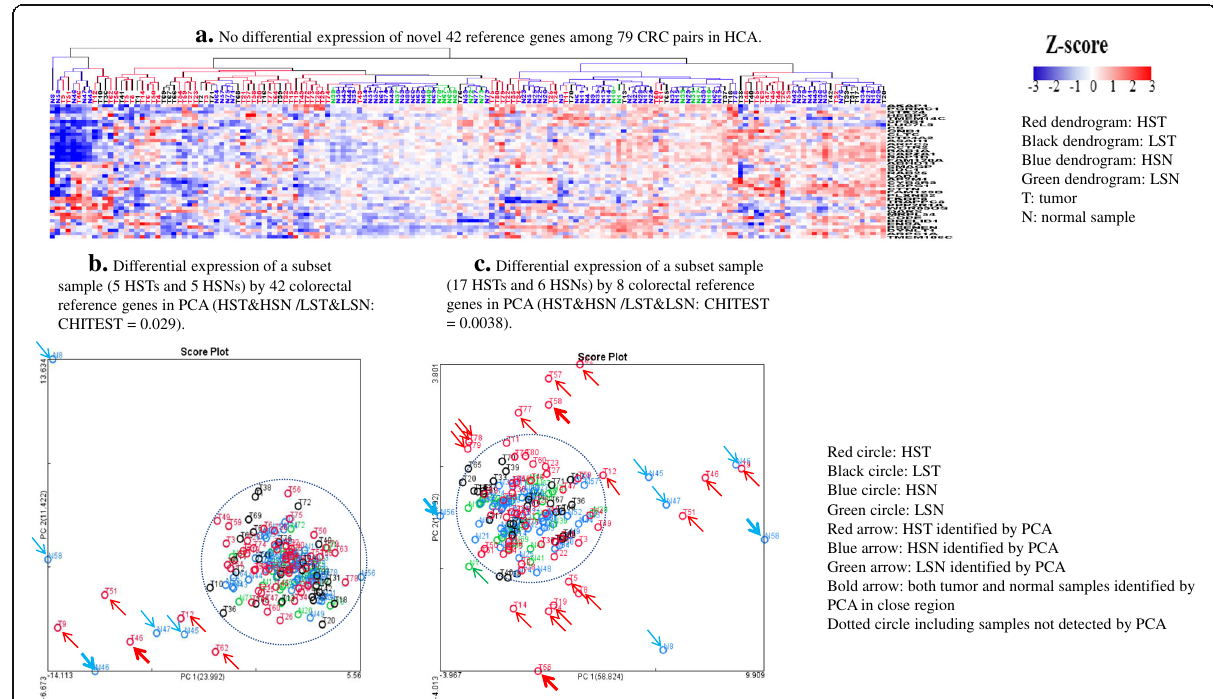
Fig. 3 HCA and PCA analysis of colorectal 42 reference genes in 79 CRC pairs. a . No differential expression of novel 42 reference genes among 79 CRC pairs in HCA. b . Differential expression of a subset sample (5 HSTs and 5 HSNs) by 42 colorectal reference genes in PCA (HST&HSN /LST&LSN: CHITEST = 0.029). c . Separation of a subset of 17 HSTs, 6 HSNs and 1 LSN by 8 colorectal reference genes (HST&N /LST&N: Chi square test =